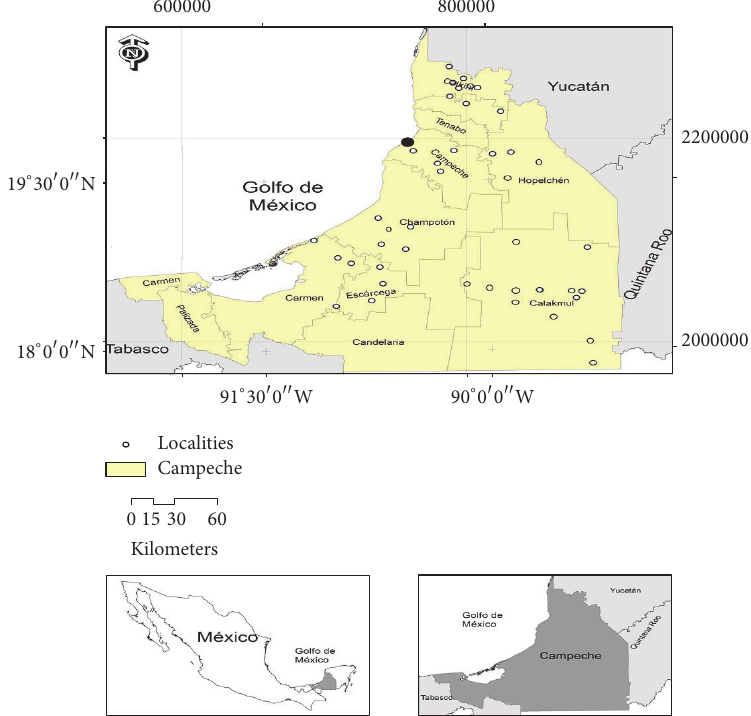
Figure 1: Geographical origin of the honey samples collected from different regions of the state of Campeche, Mexico.